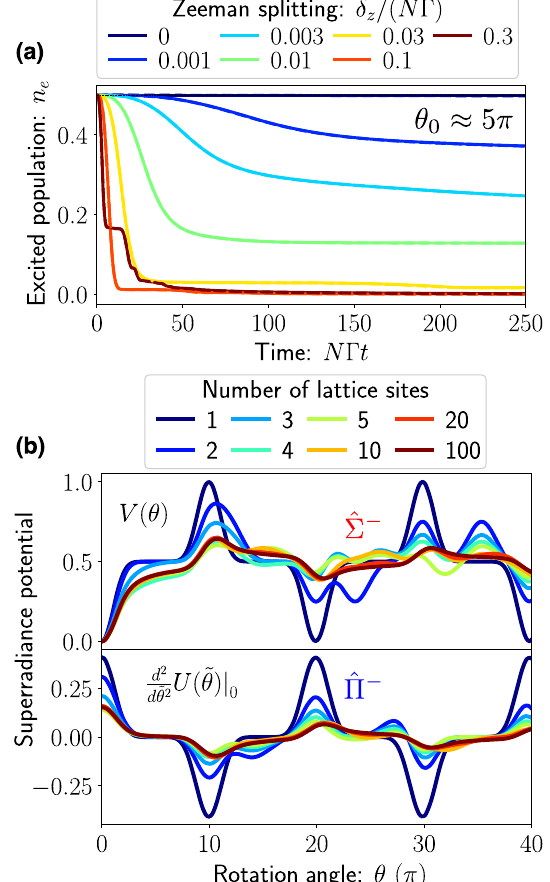
FIG. 13. Magnetic field and inhomogeneous couplings. Results 9 = 2 starting in the F for the 20-level system with F g ¼ e ¼ ˆ Σ (cid:2) state and being initially excited by a drive of pulse j g − 9 = 2 i V area θ 0 [cf. Fig. 12(a)]. (a) Time evolution of the excited-state P 1 population n h ˆ σ q e i for an initial pulse θ 0 ¼ 5 π lying e ¼ m N m e m at the saddle point of V ð θ Þ . Shown are MF (solid) and TWA (dashed) simulations averaged over 10 4 trajectories for N ¼ 10 4 2 δ ≡ δ = ð N Γ Þ with δ and for different Zeeman splittings δ 3 z g ¼ e z (motivated by Ref. [139]). Note that dashed lines are not visible because they lie on top of the solid MF lines of the same color. = ð N Γ Þ , the system decays into a dark state. For small enough δ z ˆ Σ − (b) Superradiance potential V ð θ Þ for decay (upper panel) and ˜ θ 2 ˜ θ ˆ Π − for curvature of the orthogonal potential ð d 2 =d Þ U ð Þj ˜ θ ¼ 0 decay (lower panel) for a system with inhomogeneous couplings. We show results for different number of lattice sites (color lines) 813 nm and λ 689 nm [32]. The one-site computed for λ L ¼ c ¼ case ( i ¼ 0 ) corresponds to Fig. 12(a). For more sites, the potential is modified but still contains stable dark